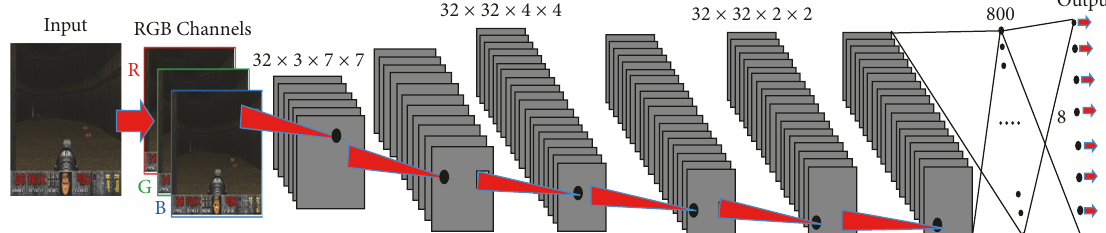
Figure 3: The proposed convolutional neural network (CNN) architecture employed in